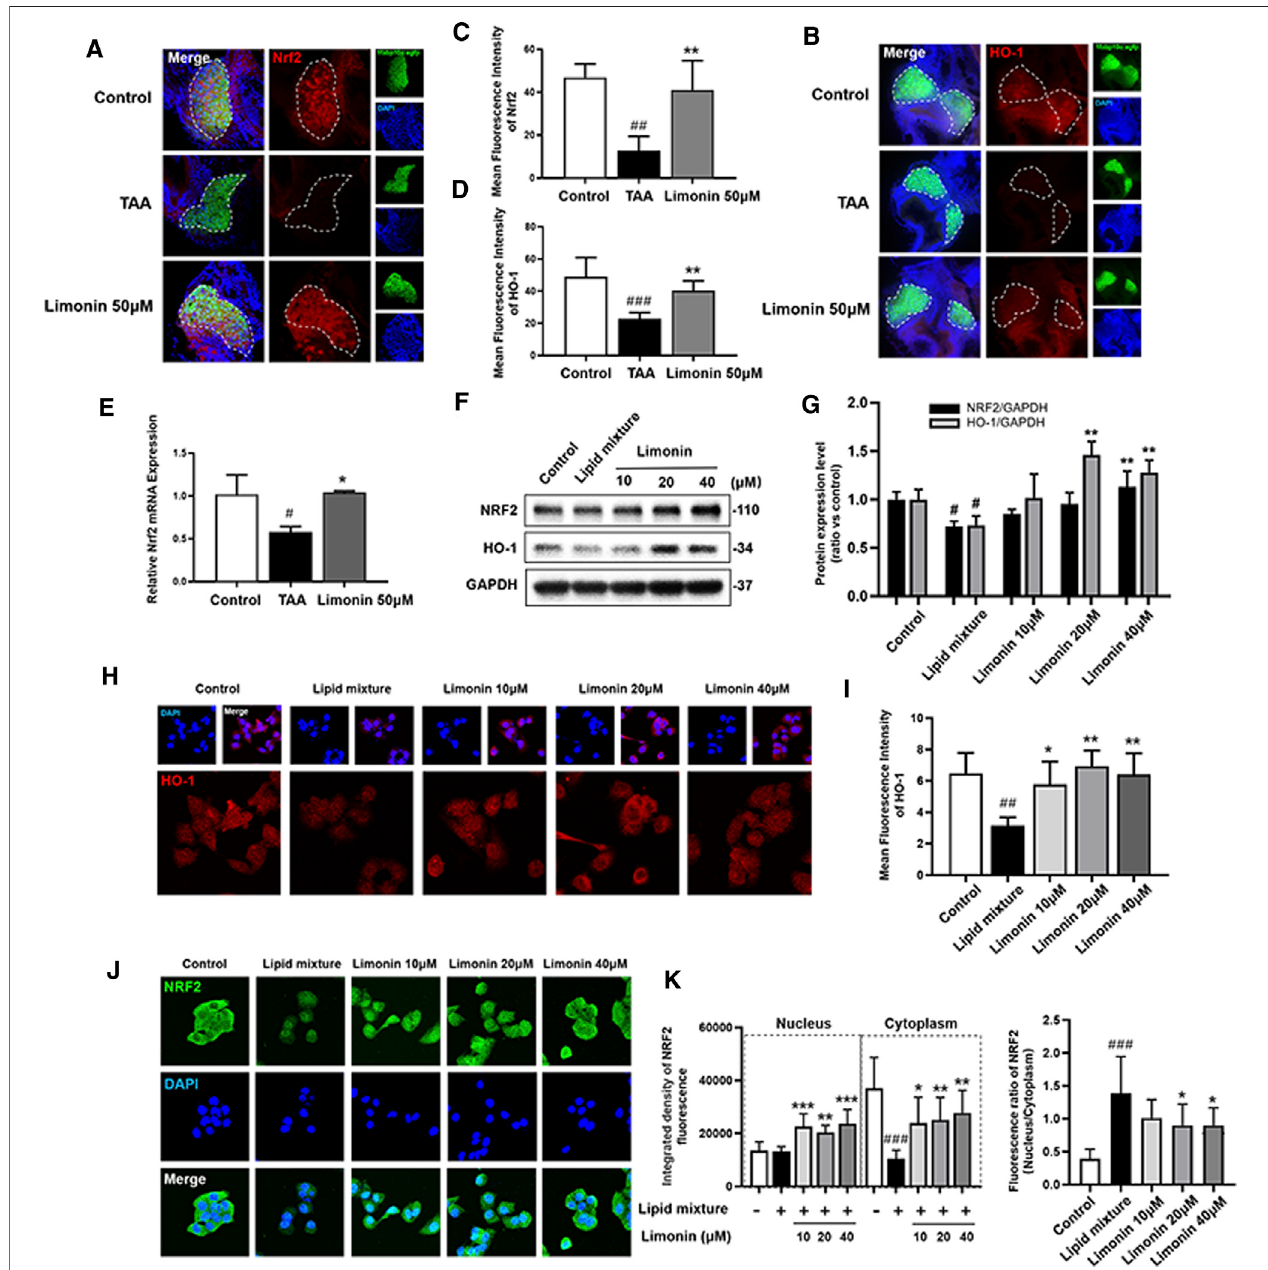
FIGURE8 | Limonin exerts the effectofanti-oxidative stress through the NRF2/HO-1 pathway. (A) Frozen liver sections ofzebra fi sh larvae with liver-speci fi c eGFP expression were immuno fl uorescent stained with NRF2 ( n (cid:1) 6 – 8 per group). (B) Immuno fl uorescence staining of HO-1 in zebra fi sh larvae ( n (cid:1) 6 – 8 per group). (C – D) Quantitative analysis of the liver mean fl uorescence intensity of NRF2 and HO-1. (E) Real-time PCR analysis of NRF2 mRNA levels in zebra fi sh larvae. The mRNA levels were normalized to β -actin mRNA levels and presented as fold change compared with the control group ( n (cid:1) 3 per group). (F) Western blot analysis of the expression of HO-1 and NRF2. GAPDH was used as an internal control. (G) Relative quantitative protein expression of NRF2 and HO-1. (H) Immuno fl uorescence stainingofHO-1 inLO2 cells. (I) Cellular fl uorescence intensityofHO-1. (J) Immuno fl uorescence staining ofNRF2 in LO2cells. (K) The respective fl uorescence intensity of the nucleus, cytoplasm and ratio of NRF2. Data are shown as the mean ± SD from three independent experiments. # p < 0.05, ## p < 0.01, ### p < 0.001 vs control group; * p < 0.05, ** p < 0.01, *** p < 0.001 vs TAA group.